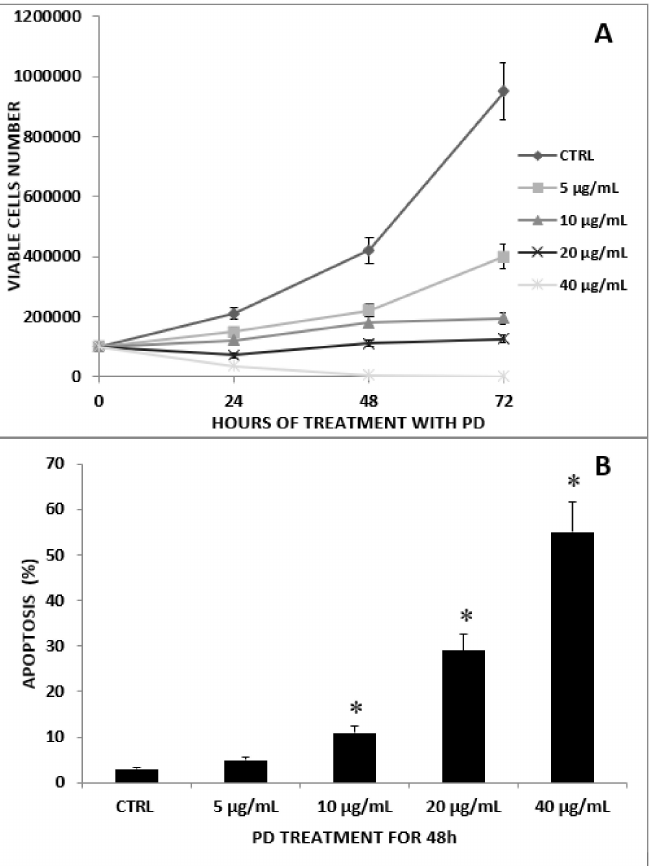
Figure 1. HT-29 cell growth and apoptosis induction. ( A ) Time course of the antiproliferative effect of graded concentrations of PD on the HT-29 tumor cell line. The cell proliferation was determined by cell counts in trypan blue. Data are expressed in terms of the number of viable cells. Measurements were done in triplicate, and bars represent ± SE of the mean of three separate counts. Values are referred to a representative experiment from at least three independent experiments. ( B ) Apoptosis induction in HT-29 cancer cells with graded concentrations of PD. Cells were cultured in CM alone (control) or CM containing the indicated concentrations of PD for 48 h. At the end of the culture period, the cells were harvested and the percentages of apoptotic cells were evaluated by flow cytometry. Data expressed as the mean of the percentage of cells in apoptosis from at least three independent experiments. * p ≤ 0.01 with respect to untreated